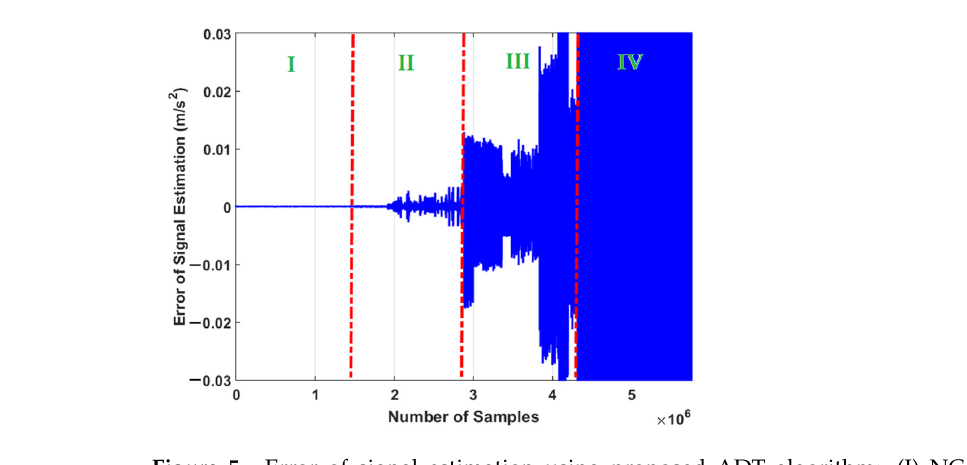
Figure 4. Error of system modeling using the proposed MGPRLF, GPRLF, and GPR algorithms.